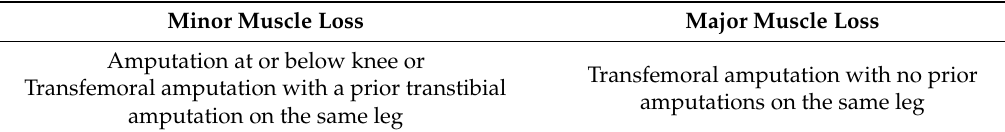
Table 1. Definition of minor and major muscle loss according to the amputation